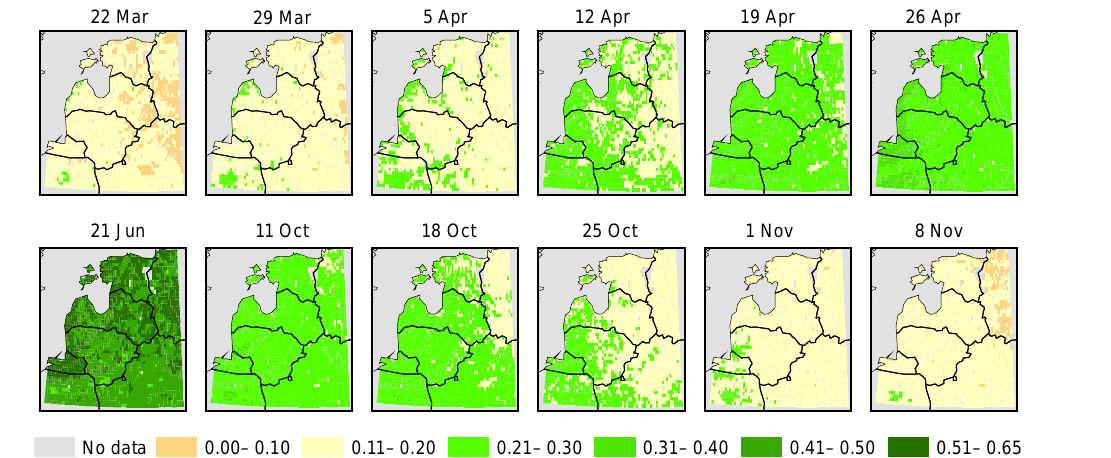
Figure 2. Median of weekly 1982–2014 NDVI in spring (from 22 March to 26 April), autumn (from 11 October to 8 November) and during the vegetation peak (18–24 June) in the eastern part of the Baltic Sea region. Dates are the midpoints of weekly NDVI data.